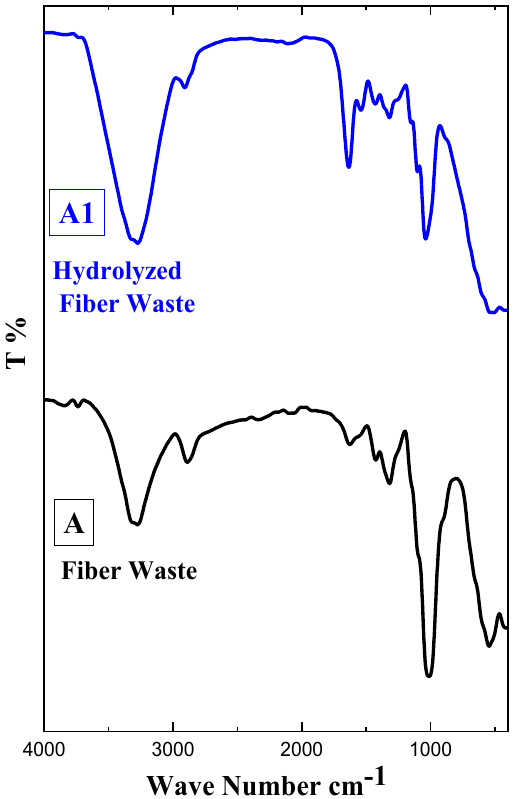
Figure 7. FTIR of cellulosic fiber waste; A: before hydrolysis and A1: after hydrolysis.